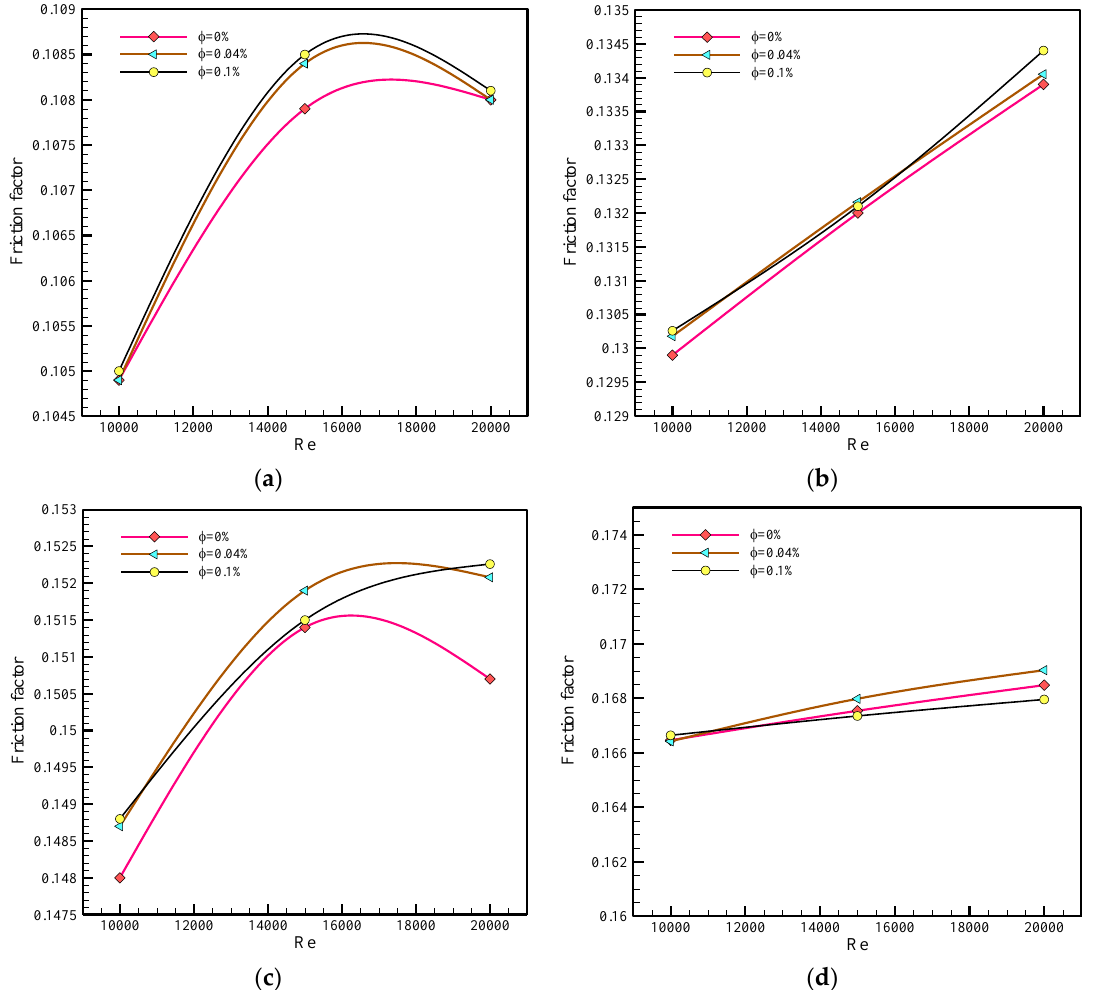
Figure 11. Friction factor against Reynolds number at various solid volume fractions through shell and tube heat exchanger with baffle angle of ( a ) 45°, ( b ) 90°, ( c ) 135°, and ( d ) 180°.